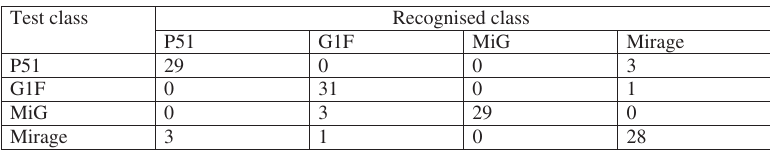
Figure 19: Classification